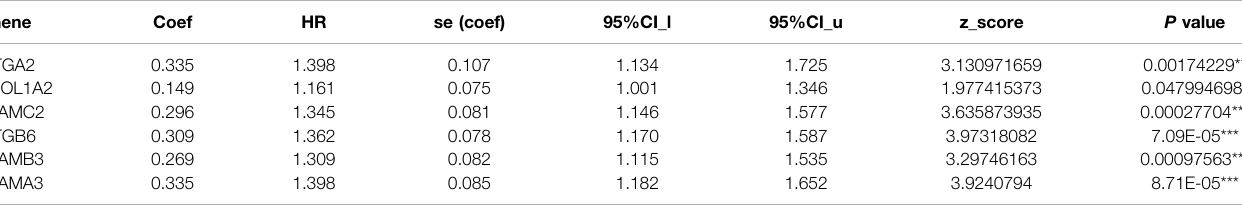
TABLE 1 | Cox proportional hazard regression model for OS in patients with PAAD.